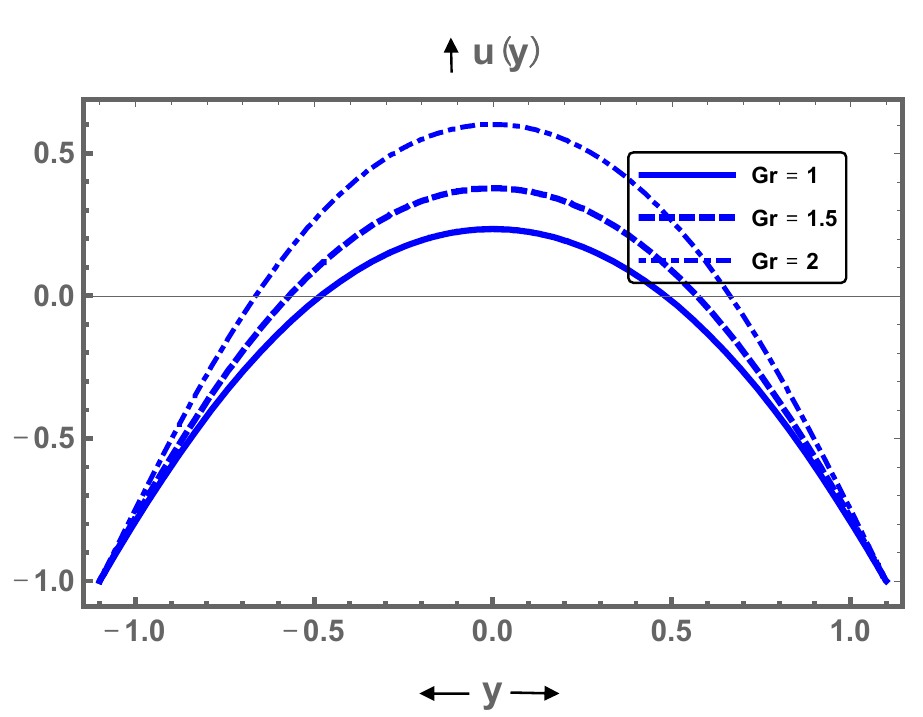
Figure 12. Display of axial velocity for different values of Gr .